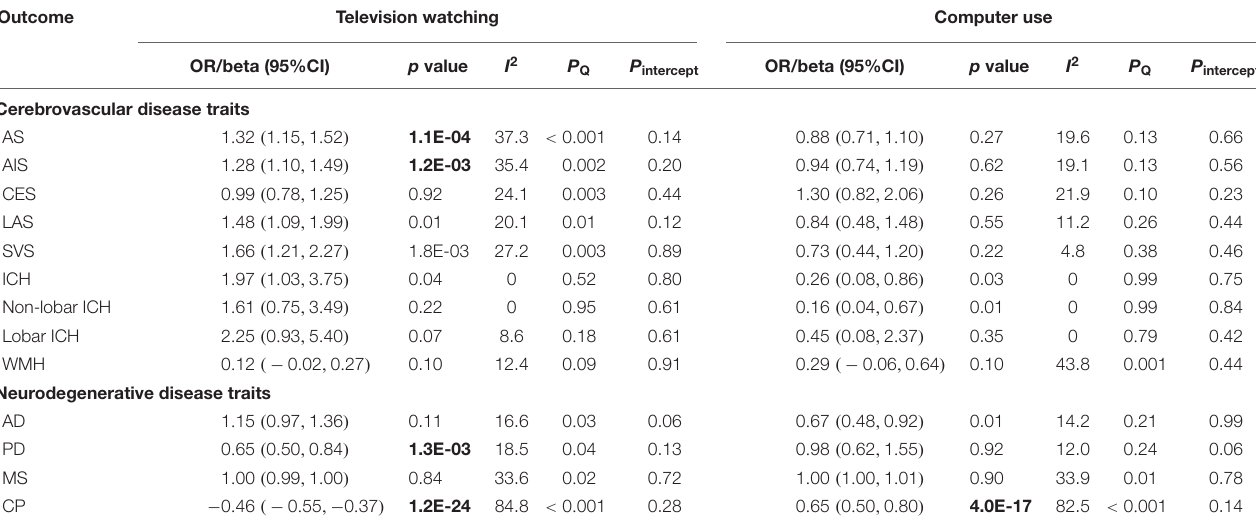
TABLE 1 | Mendelian randomization association of genetically determined sedentary behaviors with cerebrovascular disease traits and neurodegenerative disease traits. Outcome Television watching Computer